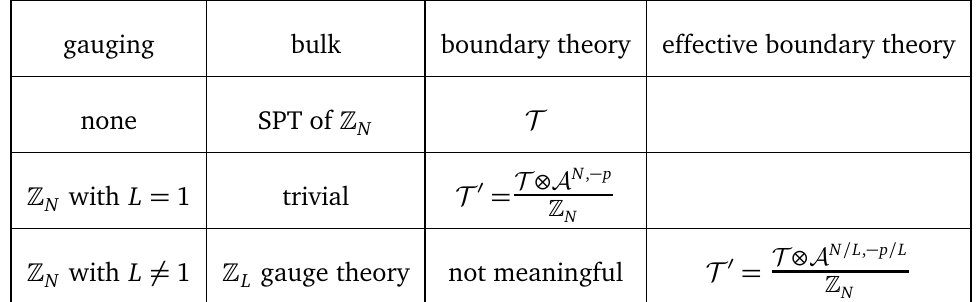
Table 3: Gauging an SPT phase of (cid:90) one-form symmetry with a boundary supporting N a 3d TQFT leads to a 4d-3d system. It is not meaningful to discuss the resulting T boundary theory unless the bulk is trivial. This happens when L = gcd ( N , p ) =